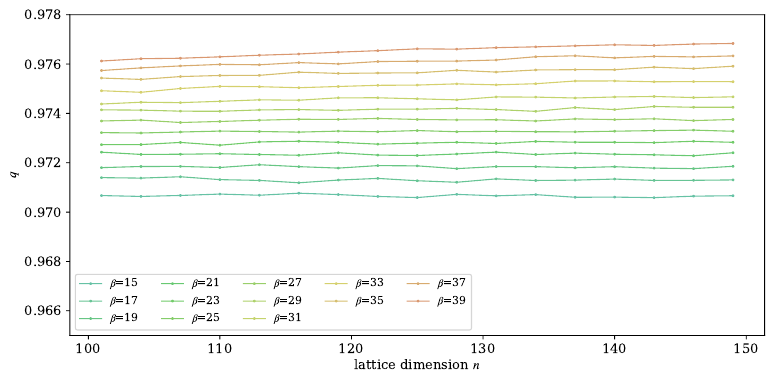
Figure 4. The relation between q and lattice dimension n